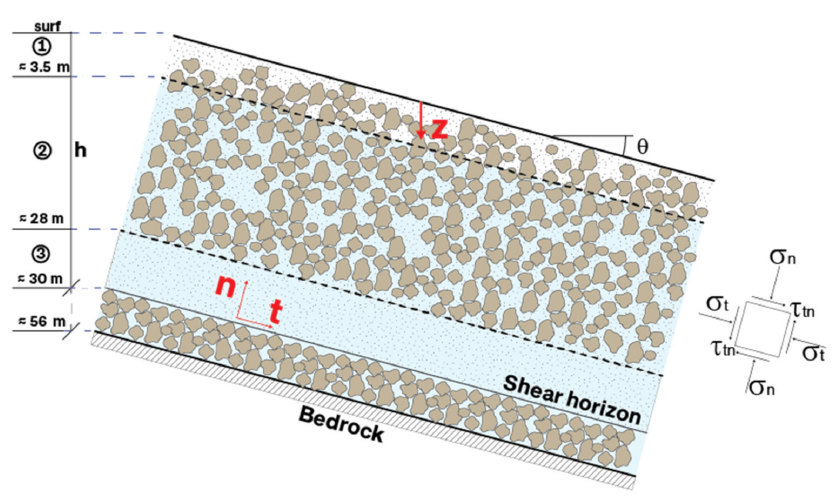
Figure 3. Schematic profile of the Murt é l-Corvatsch rock glacier (after